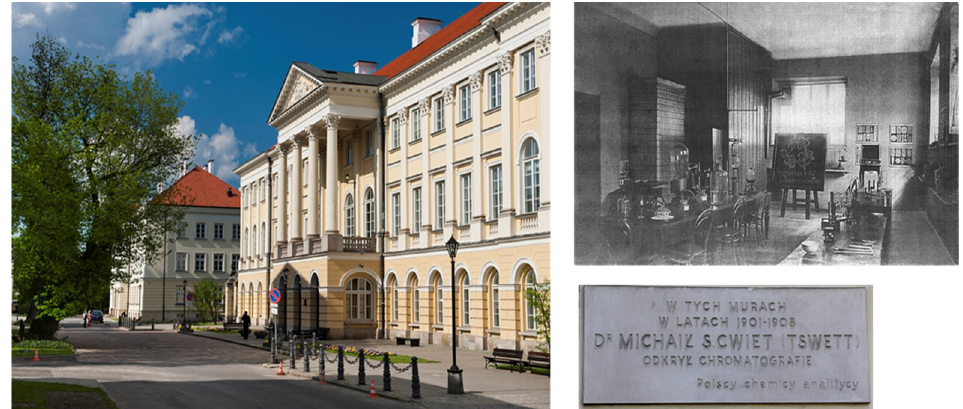
Figure 2. The building of the University of Warsaw with the Tswiett’s laboratory and a memorial plaque commemorating the discovery of chromatography.